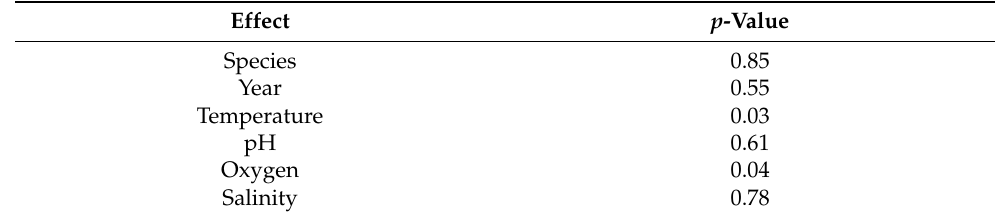
Table 7. Results of the generalized linear model applied to OA levels assuming a lognormal distribution.